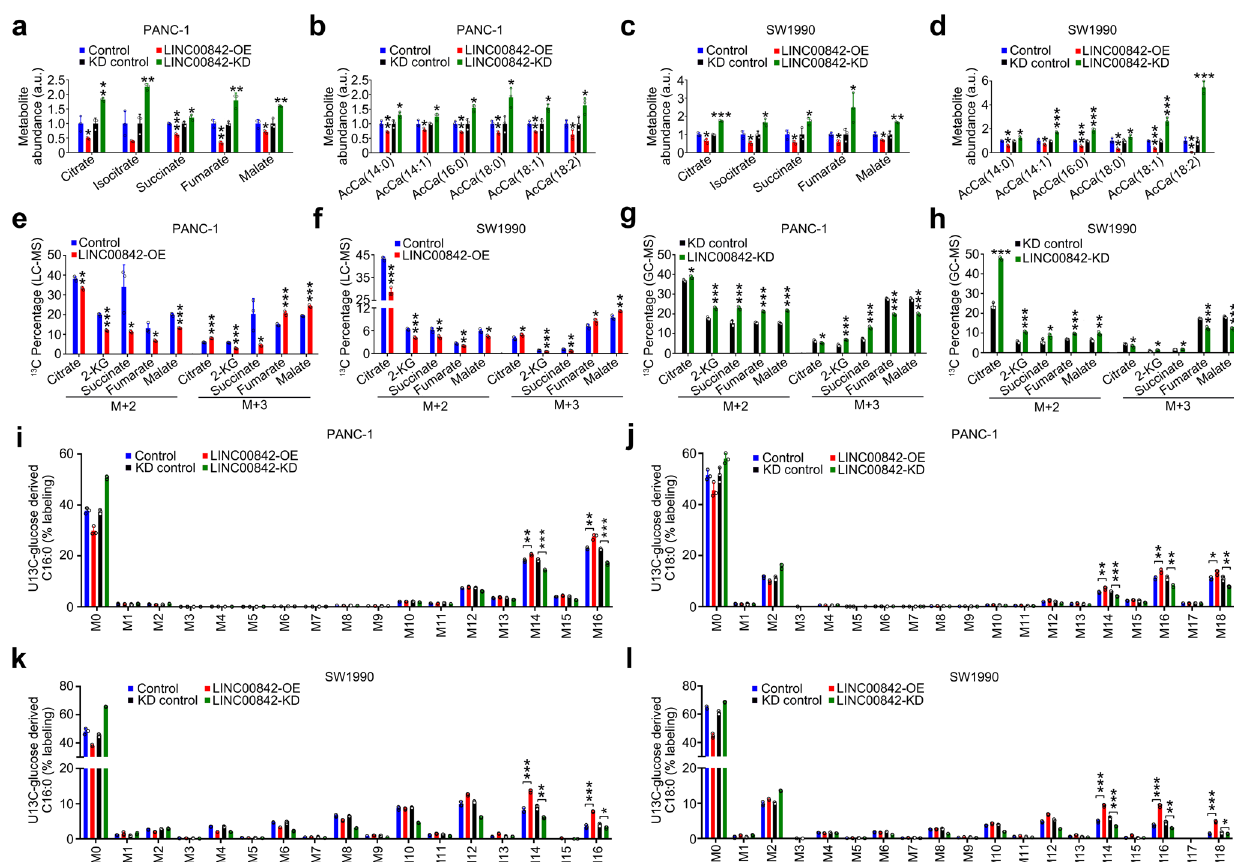
Fig. 3 LINC00842 promotes anabolic metabolism in PDAC cells. a – d LINC00842 expression change signi fi cantly altered the abundance of tricarboxylic acid cycle (TCA) intermediates ( a and c ) or long-chain acylcarnitines ( b and d ). e – h LINC00842 overexpression (OE) or knockdown (KD) signi fi cantly changed the levels of TCA intermediates expressed as mass isotopomer percentage. i – l LINC00842 expression change signi fi cantly altered the levels of palmitate (C16:0, i and k ) and stearate (C18:0, j and l ) paired mass isotopomer percentages. Results in ( a – l ) are mean ± SD from 3 independent experiments. * P < 0.05; ** P < 0.01, and *** P < 0.001 were determined by Student ’ s t -test